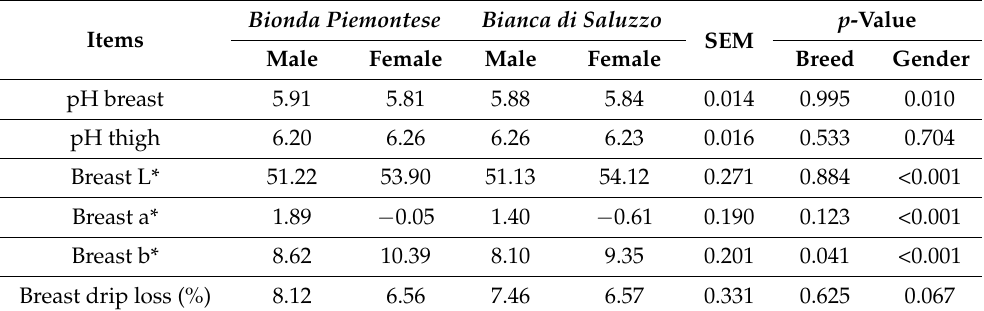
Table 3. Average meat quality parameters for breast and thigh of Bionda Piemontese and Bianca di Saluzzo breeds. Data are the average of the four consecutive slaughterings at 5, 6, 7, and 8 months of age ( n =